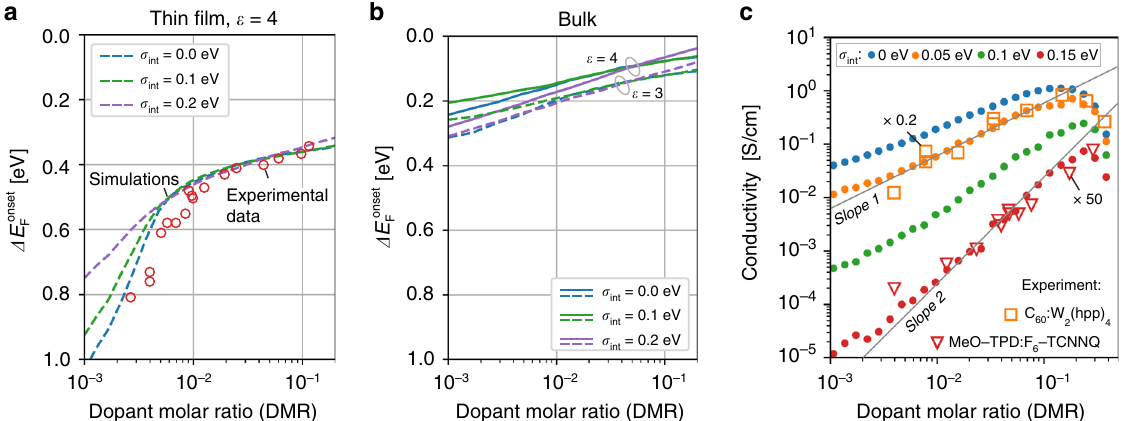
, in the Fig. 4 Experimental and simulated Fermi level shift and conductivity upon doping. a Shift of the Fermi level with respect to the HOMO onset, Δ E onset F center of a 15 nm doped organic fi lm with ε = 4 and various magnitude of the intrinsic disorder ( σ int ) in comparison with UPS measurements 27 of MeO- TPD doped with fl uorinated fullerene C 60 F 36 . Simulated curves are shifted down by 0.3 eV to account for the difference in surface and bulk polarization energies 14 . b Shift of the Fermi level with respect to the HOMO onset, Δ E onset , computed for a bulk material. c , Conductivity as a function of the DMR in F doped bulk systems with ε = 4 and various intrinsic disorder strengths in comparison with experimental data 16,28 for low and highly disordered materials at an electric fi eld strength of 0.04 V nm − 1 . In the moderate doping regime (10 − 3 < DMR < 10 − 1 ), the conductivity increases either sublinearly (low disorder) or superlinearly (high disorder) upon